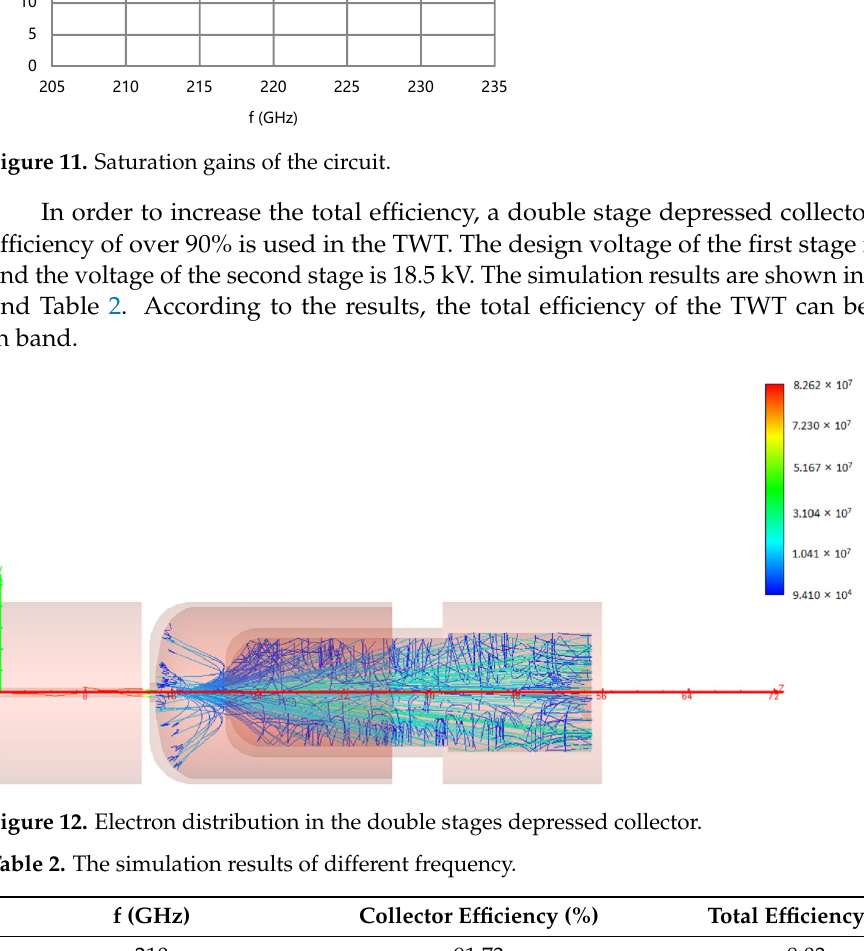
Figure 11. Saturation gains of the circuit.